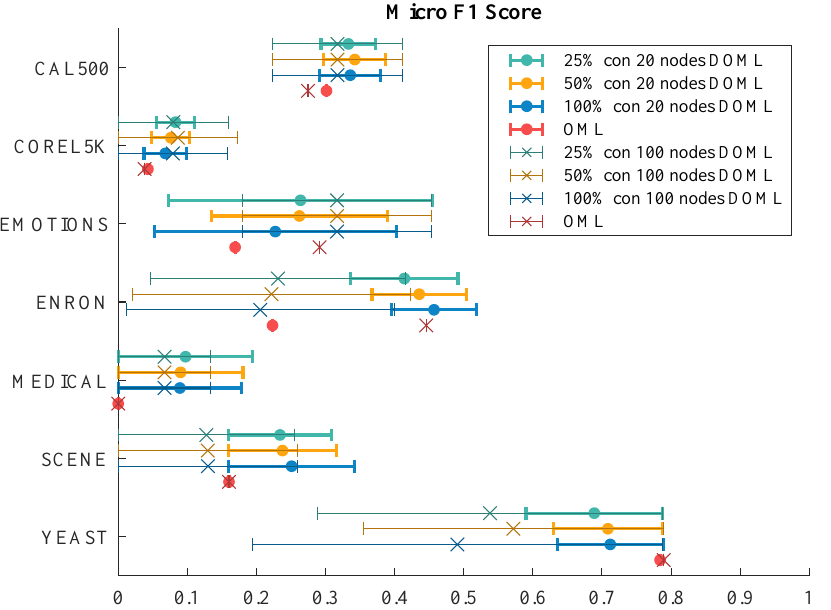
Figure 7. Micro F1 Score of DOML in a 100-node network with different connectivity and OML with same amount of instances as each